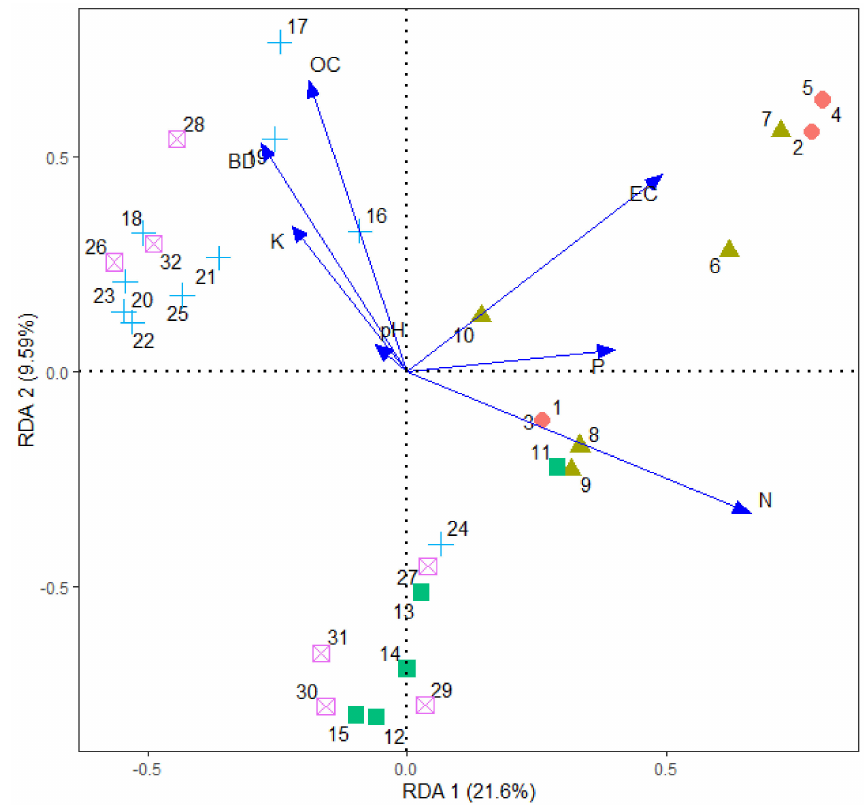
Figure 11. Redundancy analysis biplot for 32 sampling quadrats constrained by six soil parameters (represented by arrows). Sampling quadrats: solid-circles 1–5 are productive tea, solid-triangles 6–10 are marginal tea, solid-squares 11–15 are scrub, pluses 16–25 are WD1, and crossed-squares 25–32 are—WD2 in the Endane Biodiversity